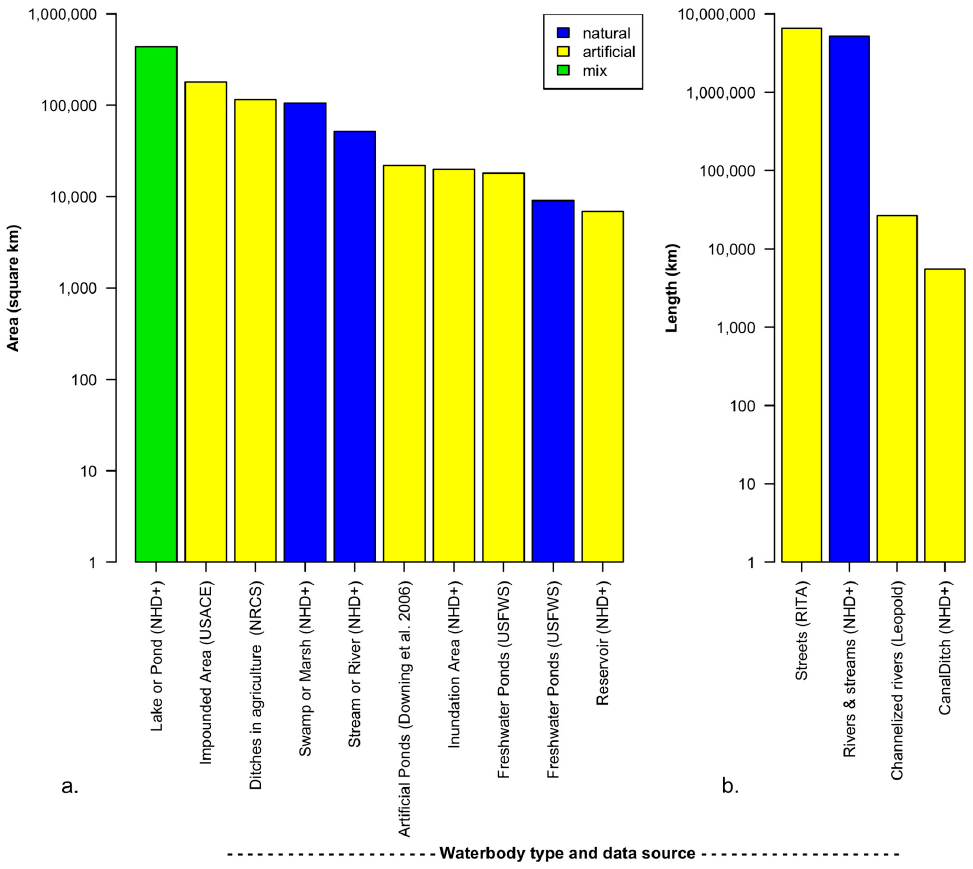
Figure 2. Extent of artificial as compared to natural waterbodies in the U.S. Data drawn from a variety of sources, shown in parentheses. ( a ) areal features; ( b ) linear features. Data are taken from the National Hydrography Dataset (NHD+) [48], U.S. Army Corps of Engineers National Inventory